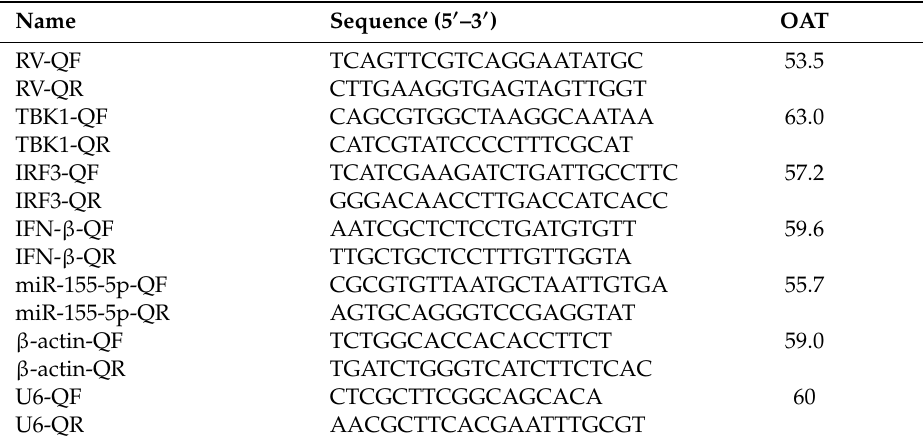
Table 2. Primer sequences and optimal annealing temperatures (OAT, ◦ C) of genes selected for analysis by real-time